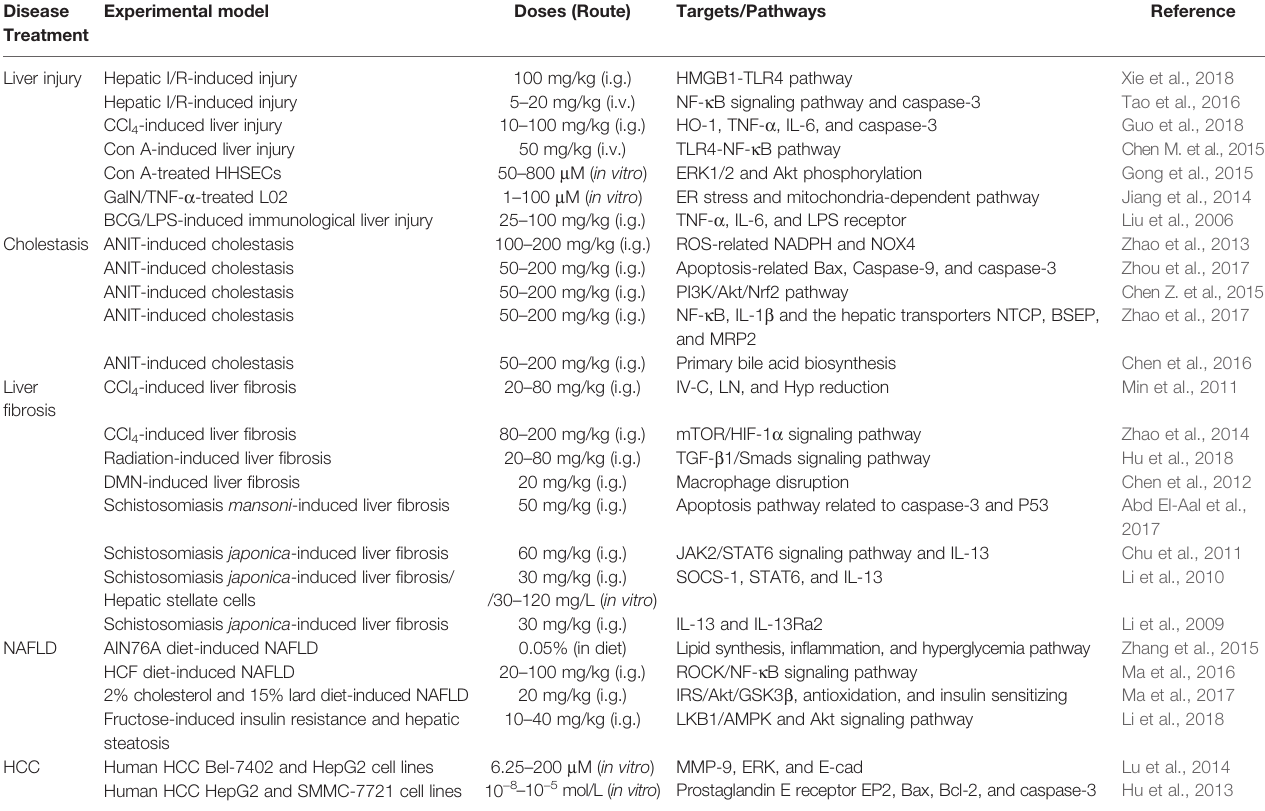
TABLE 1 | The pharmacological activities of paeoni fl orin in liver diseases. Disease Experimental model Treatment